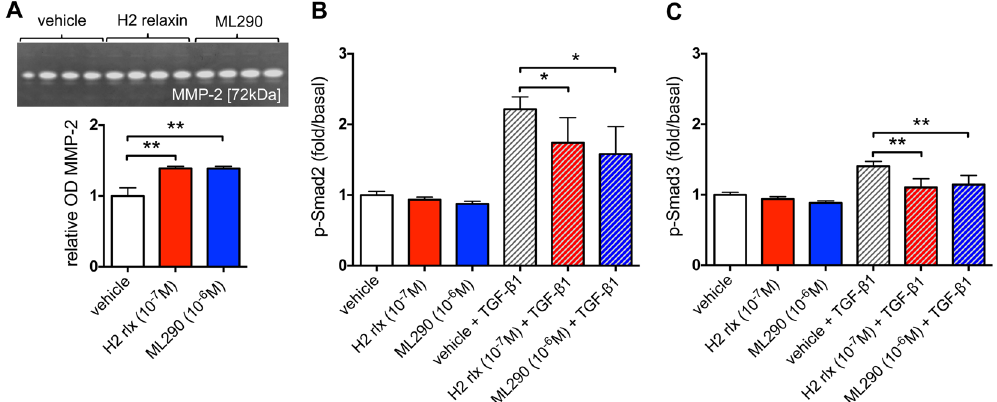
Figure 6. ML290 effects on MMP-2 expression and TGF- β 1-induced Smad2 and Smad3 phosphorylation in HCFs. ML290 (1 μ M) promoted MMP-2 activity to an equivalent extent to H2 relaxin (0.1 μ M) over 72 hours. In ( A upper) a representative cropped zymograph (see Figure S4) of duplicate samples from two separate experiments; in ( A lower) mean ± SE OD MMP-2, expressed as the ratio of that of in the untreated control group. ** p < 0.01 versus untreated control group. In HCFs treated for 72 hours, ML290 (1 μ M) inhibited TGF- β 1-induced increases in p-Smad2 ( B , n = 4) and increases in p-Smad3 ( C , n = 4) to a level similar to that with H2 relaxin (0.1 μ M). TGF- β 1 (2 ng/ml) increased p-Smad2 ( B ) and p-Smad3 ( C ) compared to vehicle treated samples. Neither H2 relaxin (0.1 μ M) nor ML290 (1 μ M) had a significant effect on p-Smad2 or p-Smad3 in cells not treated with TGF- β 1 ( B , C ). Data are mean ± SEM of 4 independent experiments performed in duplicate, ** p < 0.01 and * p <